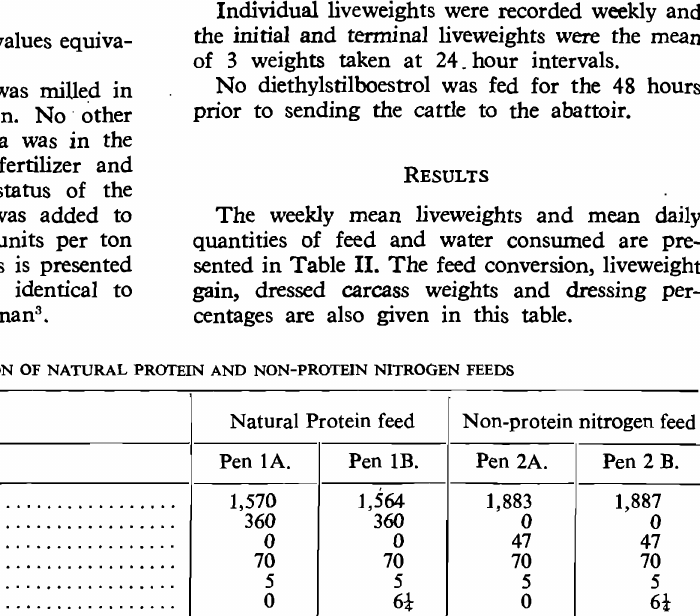
TABLE I.--COMPOSITON OF NATURAL PROTEIN AND NON-PROTEIN NITROGEN FEEDS